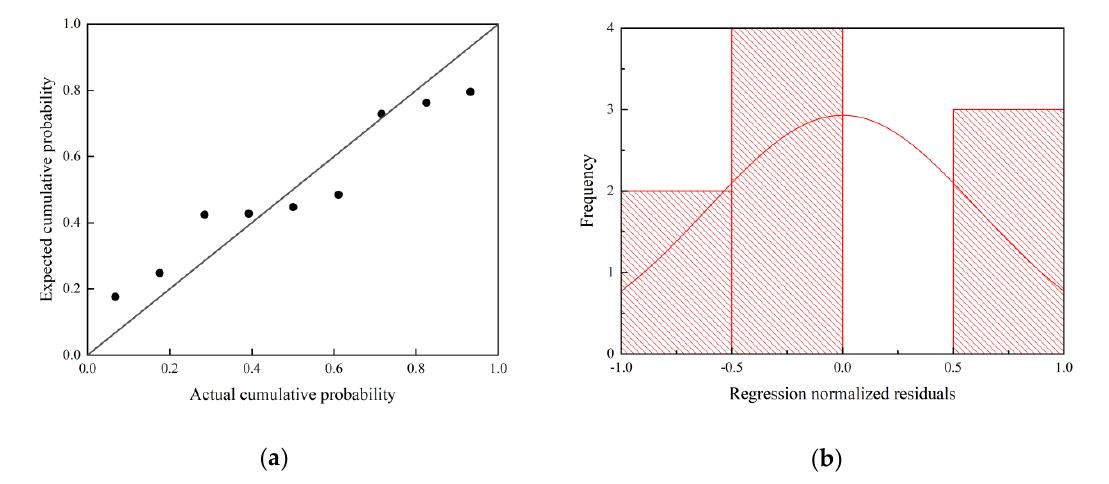
Figure 7. Regression normalized residual: ( a ) normal P-P diagram; ( b ) histogram.